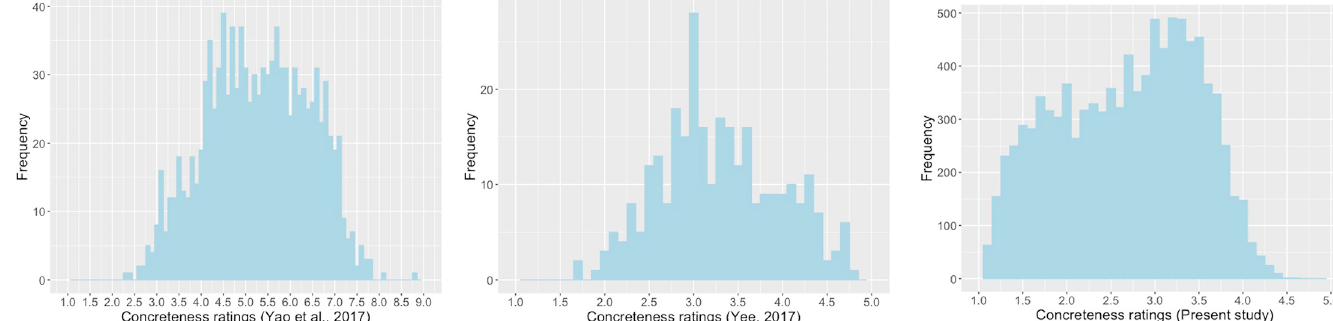
Fig 7. a. Distributions of concreteness ratings of Yao et al. [31]. b. Distributions of concreteness ratings of [32]. c. Distributions of concreteness ratings of the present study.